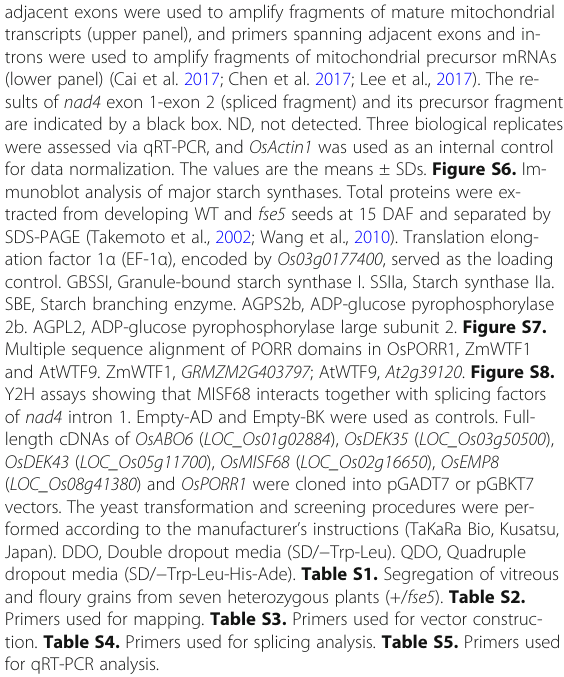
tion. Table S4. Primers used for splicing analysis. Table S5. Primers used for qRT-PCR